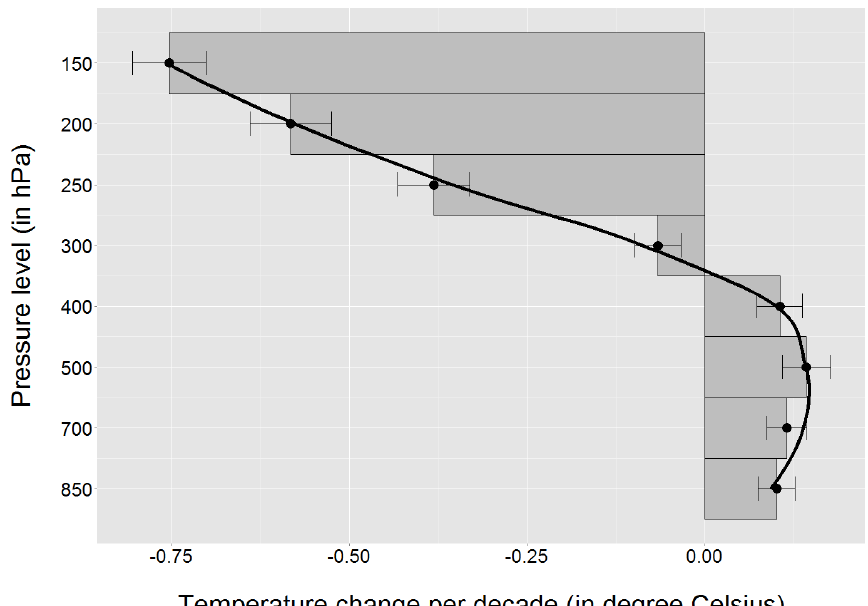
Figure 6. Midnight temperature change at the Novolazaravskaja station from October 1969 to March